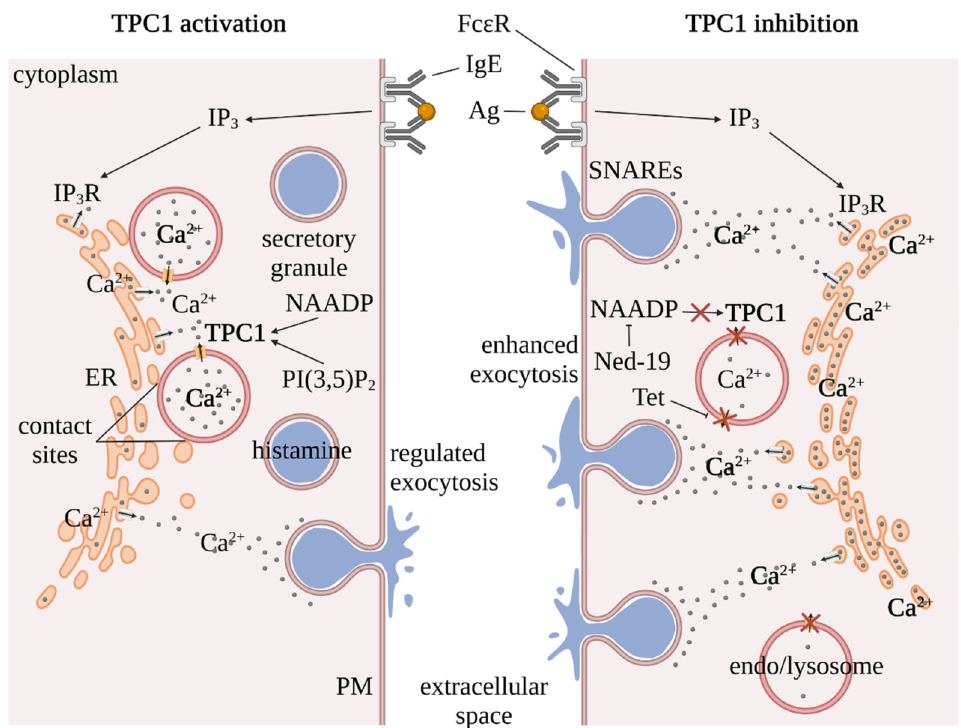
Figure 2. Illustration of the regulation of Ca 2+ homeostasis via TPC1 in mast cells. The schematic drawing on the left signifies the role of TPC1 in organellar Ca 2+ homeostasis upon IgE-induced exocytosis. Fc ε R is activated by IgE- and triggers phospholipase C, which, in turn, creates IP 3 and DAG (DAG is not depicted). Then, IP 3 binds to IP 3 R, which is located in the ER membrane and releases ER-Ca 2+ . Interestingly, a reciprocal upregulation of Ca 2+ outflow from the ER and the endo-lysosomal system has been identified, which can be regulated by a TPC1-triggered uptake of Ca 2+ into the endolysosome; thereby leading to controlled histamine release. Important agonists for TPC1 for this indirectly controlled outflow of Ca 2+ from the ER are PI(3,5)P 2 and NAADP ( left panel ). If TPC1 is inhibited pharmacologically with, for example, tetrandrine or indirectly with trans Ned-19 via NAADP-antagonization, TPC1-controlled transport of Ca 2+ into the endo-lysosomal system becomes deregulated, which subsequently leads to an accumulation of Ca 2+ within the ER ( right panel ). Consequently, Fc ε R stimulation and the followed activation of the signaling cascade triggers an elevated ER-Ca 2+ outflow which, hence, then results in an enhanced exocytosis of histamine. PM: plasma membrane; IgE: Immunoglobulin E; Fc ε R: high affinity receptor of the Fc region of IgE; ER: endoplasmic reticulum; IP 3 R: inositol 1,4,5-triphosphate receptor; NAADP: nicotinic acid adenine dinucleotide phosphate; PI(3,5)P 2 : phosphatidylinositol 3,5-bisphosphate; SNARE: soluble NSF attachment protein receptor; red crosses: inhibition of TPC1 by Tet or Ned-19 (via NAADP). Created with BioRender.com, accessed on 29 March 2022.